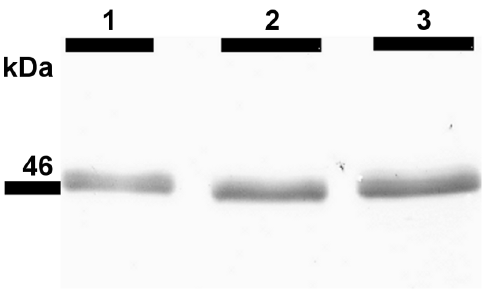
Figure 4. Western blot analysis of AMCase in the stomachs of three different bat species. Lane 1= Plecotus auritus , lane 2= Myotis myotis , lane 3= Nyctalus leisleri . Primary antibody dilution 1:1000.